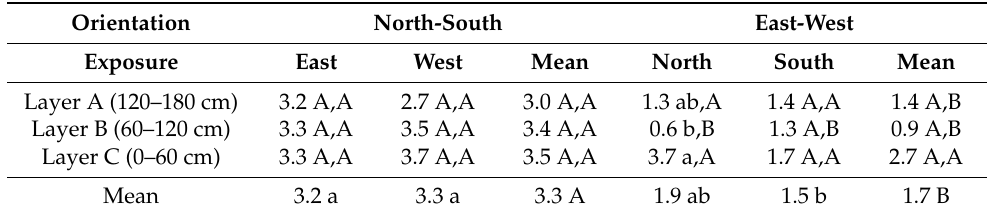
Table 13. Mean percentage of hull-tight nuts (HT, %). The first letters denote significant differences between layers for a given exposure; the second letters denote significant differences between exposures for a given layer (SNK test). Lower case letters denote statistical differences with p = 0.05. Capital letters denote statistical differences with p = 0.01.